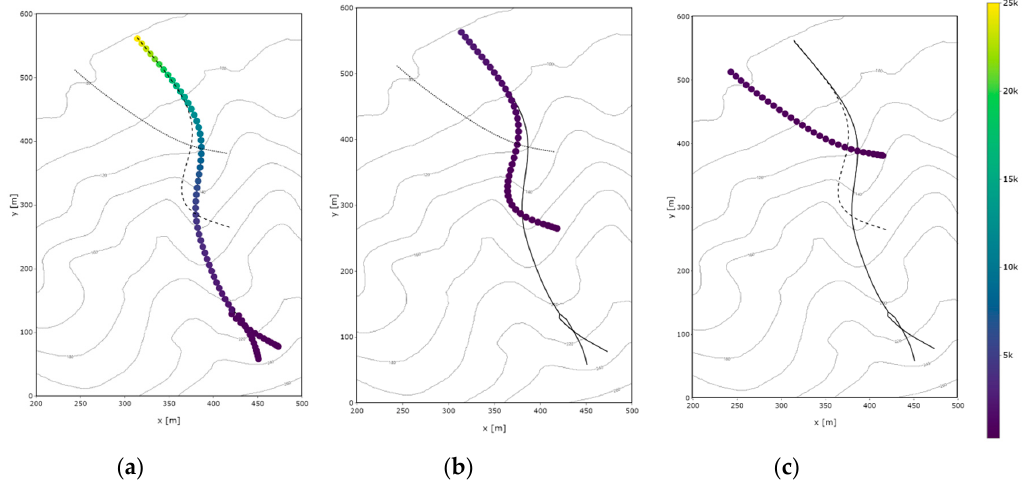
Figure 16. The hazard assessment map generated from the developed framework showing the volume (unit: m 3 ) of debris-flow clusters for ( a ) flowpath A, ( b ) flowpath B, and ( c ) flowpath C. The flowpaths are plotted separately for clarity.